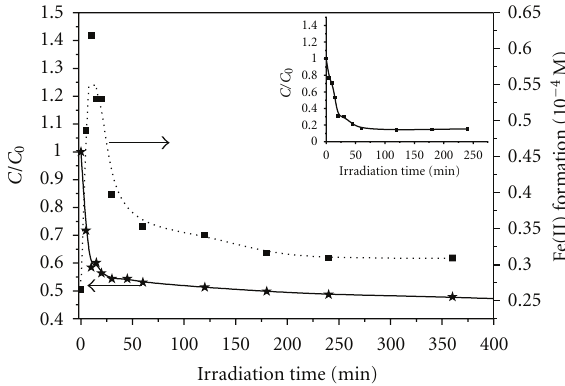
Figure 7: Kinetics disappearance of m-cresol in the mix- ture m-cresol/Fe(III)-Cit (0.1mM, 0.3mM) upon irradiation at λ = 365 nm and Fe(II) formation. Inset displays disappear- irradiation ance of Fe(III)-Cit complex in the mixture m-cr´esol/Fe(III)-Cit—